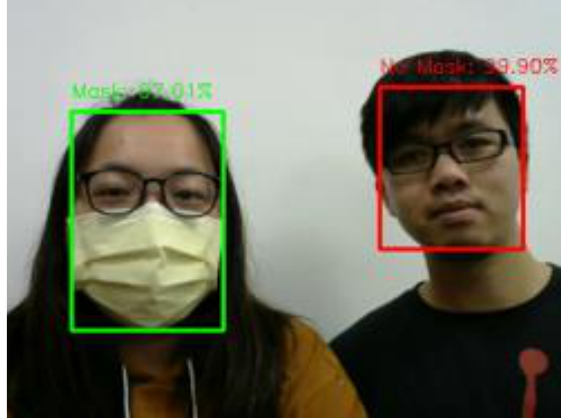
Figure 36. Mask wearing detection in real time.